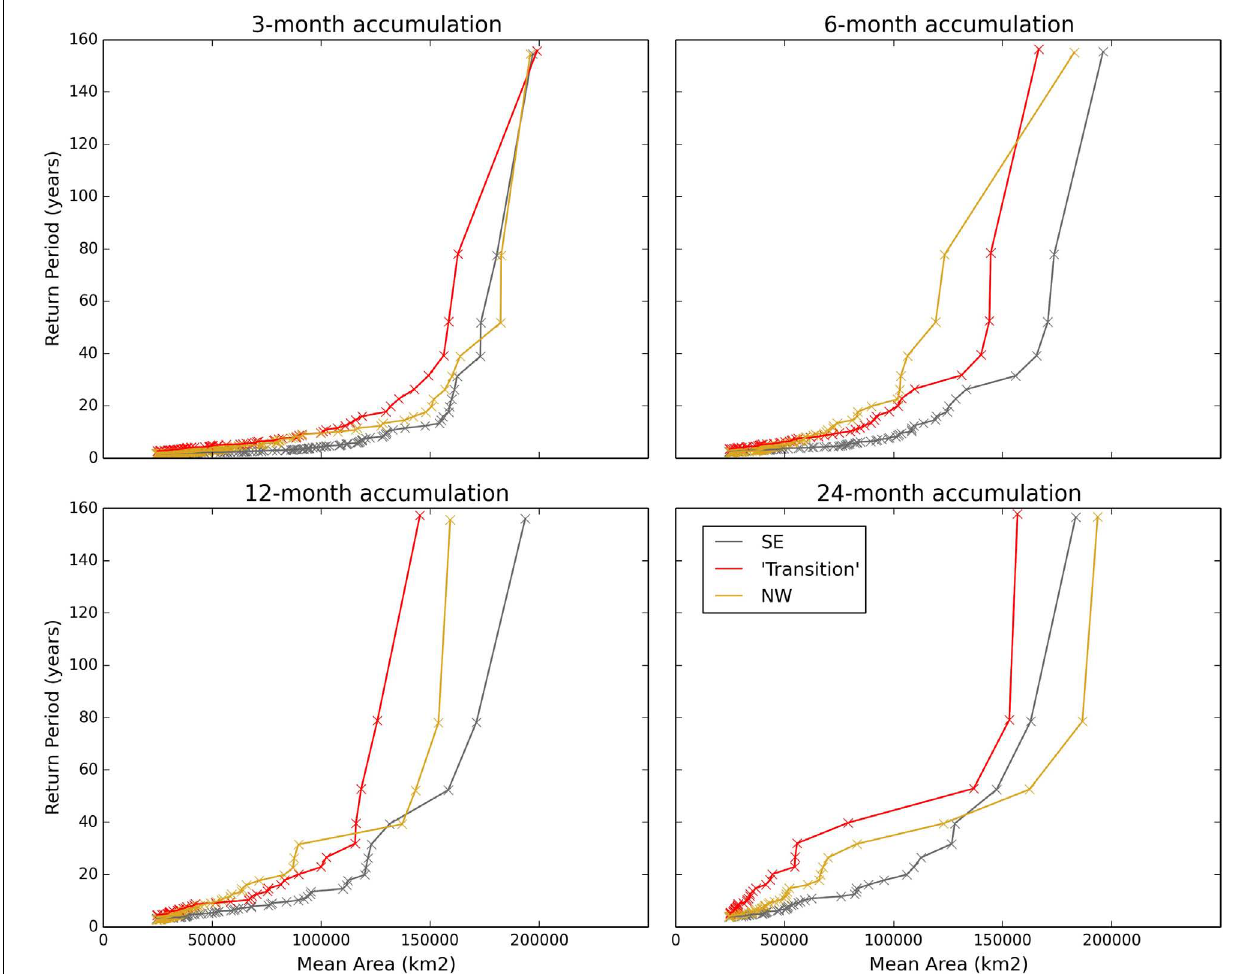
FIGURE 3 | Return period of drought events calculated based on their mean area for the three regions of GB, and for different accumulation period of precipitation (3, 6, 12, and 24